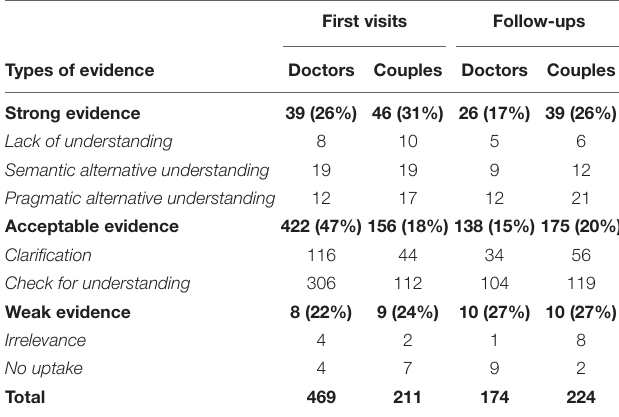
TABLE 4 | Types of misunderstanding in first and follow-up visits ( n =